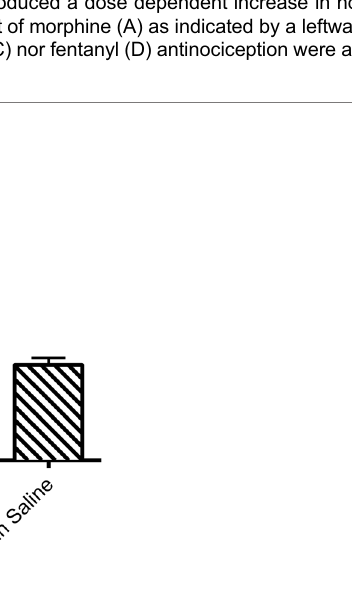
Fig. 4. Microinjection of morphine and fentanyl into the ventrolateral PAG produced antinociception on Trial 1. Despite different doses and test times, microinjection of morphine (tested 30 min after a dose of 5 m g, N 5 32) or fentanyl (tested 3 min after a dose of 3 m g, N 5 33) produced a significant increase in hot plate (HP) latency compared to saline treated controls tested 30 or 3 min after the microinjection (F(3,136) 5 51.60; p 5 .0001).